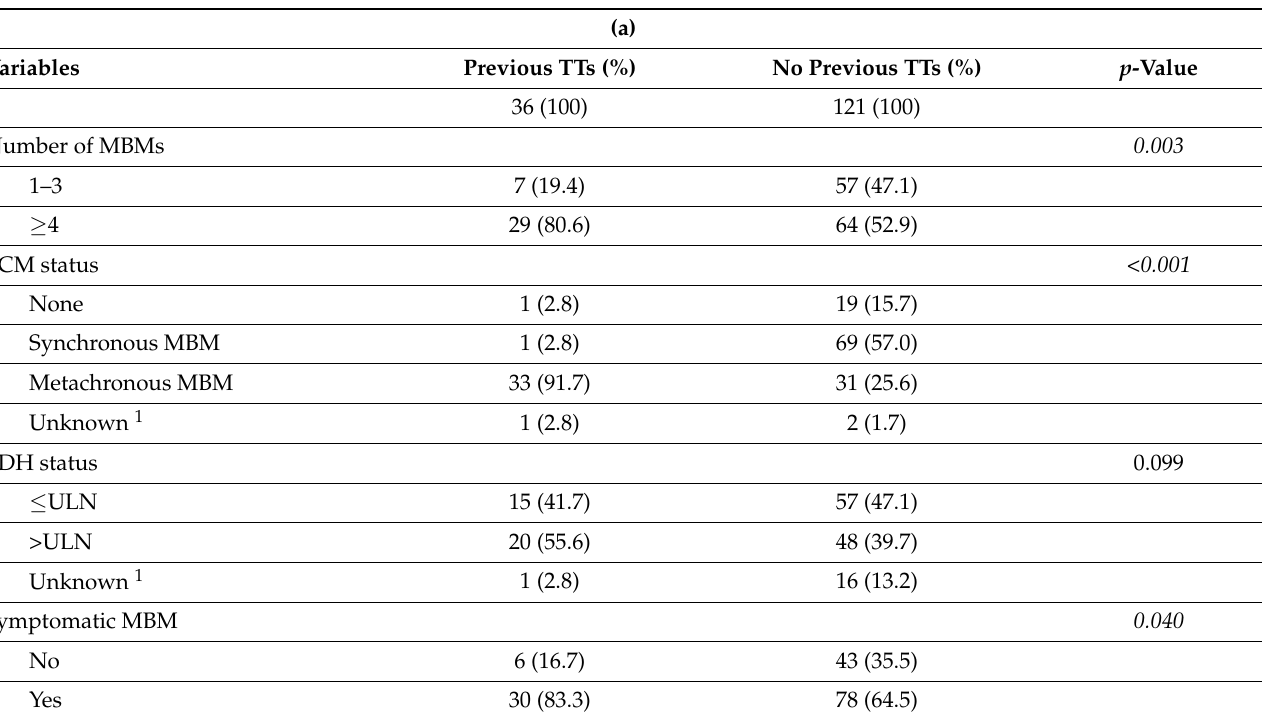
Table A5. ( a ) Baseline characteristics of patients with a BRAF V600E+/K mutated melanoma and melanoma brain metastasis (MBM) from the post-2015 cohort ( n = 157) treated with and without targeted therapies (TTs) prior to MBM diagnosis. ( b ) Baseline characteristics of patients from the post-2015 cohort ( n = 278) treated with or without immune checkpoint inhibitors (ICIs) prior to MBM